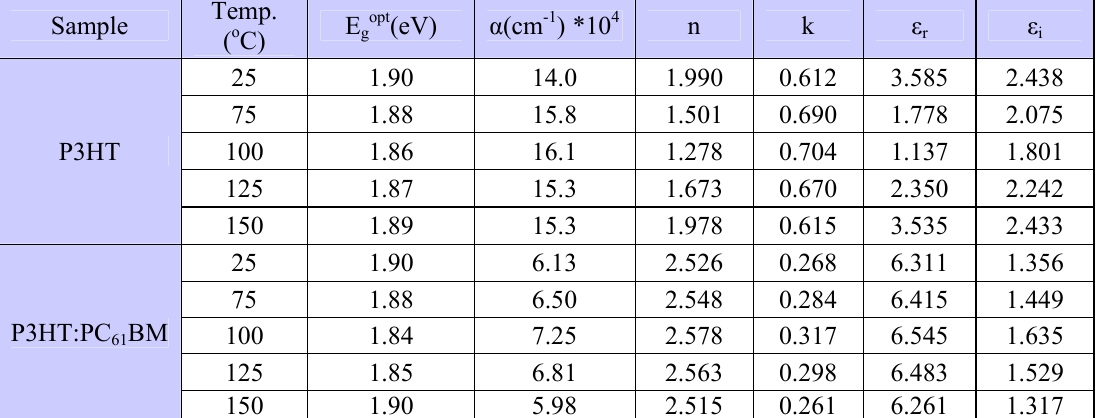
BM thin films with different 61